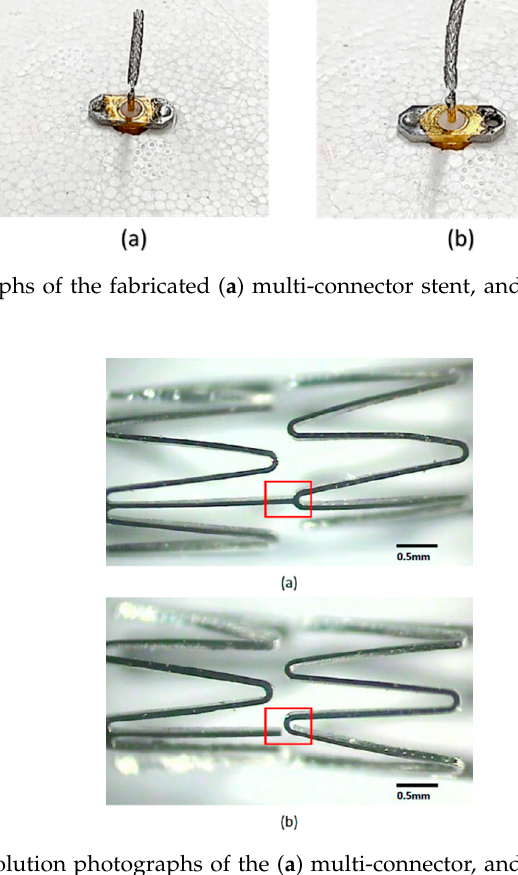
Figure 11. High-resolution photographs of the ( a ) multi-connector, and ( b ) single-connector stent antennas taken under an optical microscope.